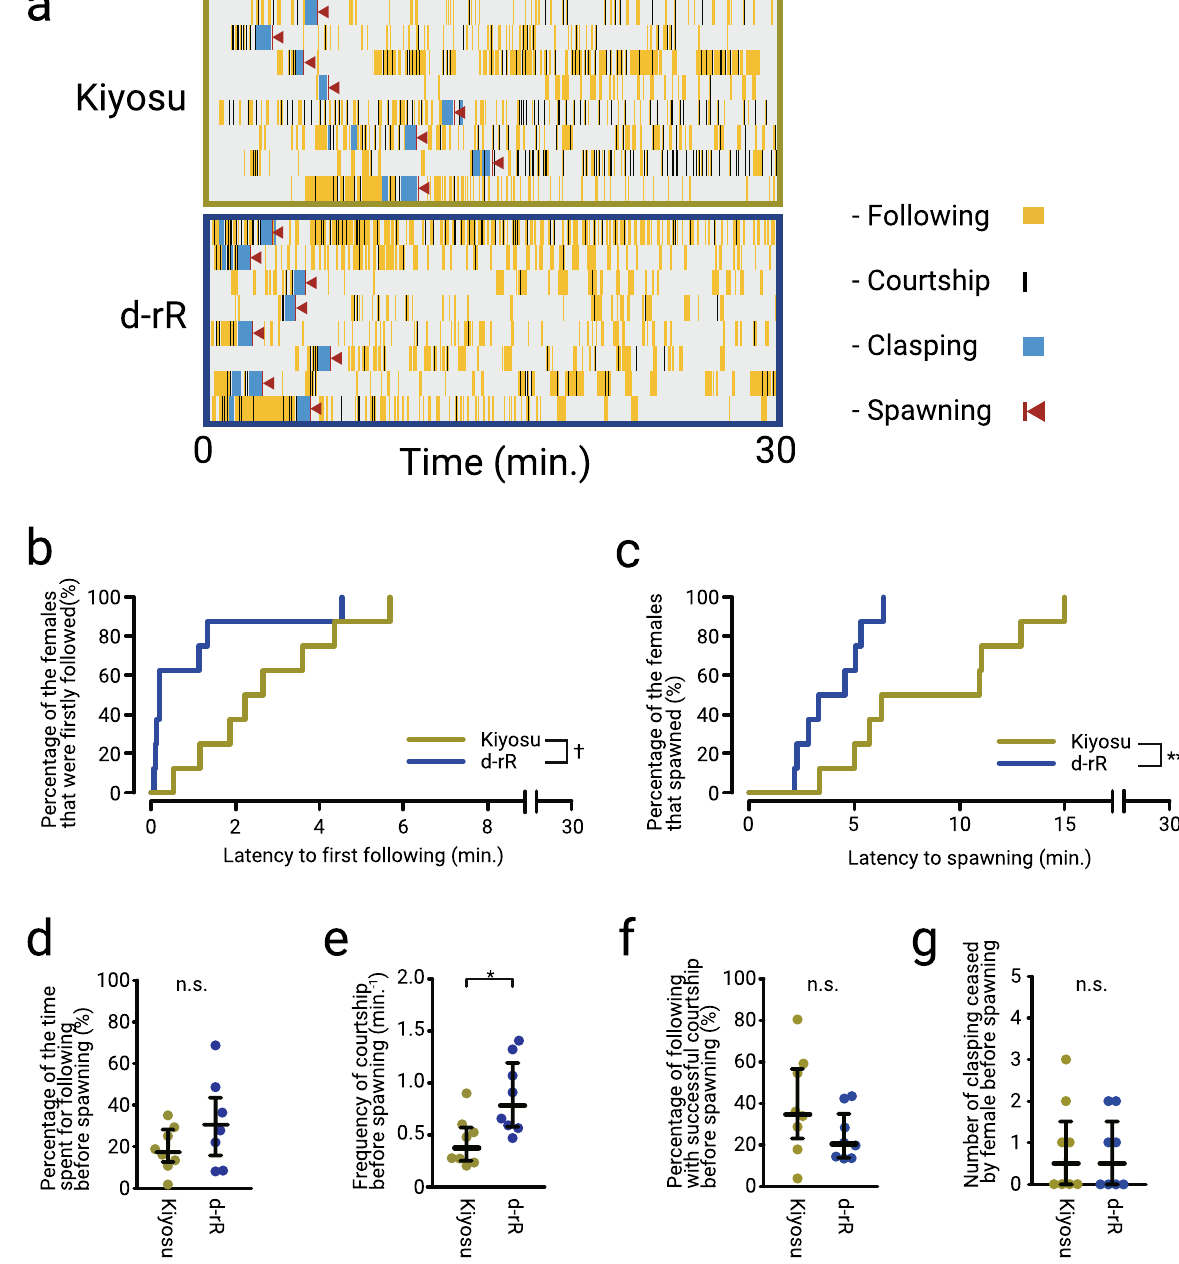
Figure 6. d-rR pairs spawn earlier than Kiyosu pairs, probably because d-rR male is more motivative to mating than Kiyosu male. ( a ) Time-course data of 30-min analyses of sexual behavior are shown as raster plots. Yellow, black, cyan and red bands represent the timing and duration of following, courtship, clasping and spawning, respectively. Red triangles are put on the right of each red bands for easy detection of them. ( b,c ) The latency data were further analyzed using Kaplan–Meier plots. Yellow and Blue curves represent Kiyosu and d-rR, respectively. d-rR pairs showed first following and spawning earlier than Kiyosu pairs ( † P < 0.1, ** P < 0.001, by Log-Rank tests). ( d – g ) Various parameters were measured and compared between Kiyosu and d-rR. Yellow and Blue dots represent Kiyosu and d-rR, respectively. The frequency of courtship before spawning was significantly higher in d-rR than Kiyosu ( e ), while no significant difference was detected in the percentage of the time spent for following before spawning ( d ), the percentage of following with successful courtship before spawning ( f ), or the number of clasping ceased by female before spawning ( g ) (* P < 0.05, by Mann–Whitney U